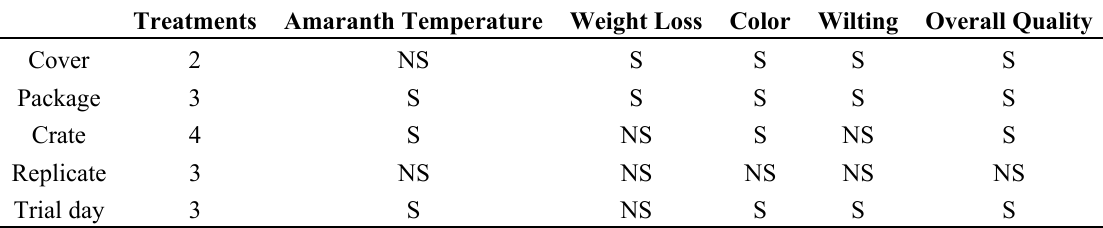
Table 5. Results of overall statistical analysis on effects of consumer package type and pallet cover on amaranth temperature, weight, color, overall quality and degree of wilting during six hours of storage at ambient